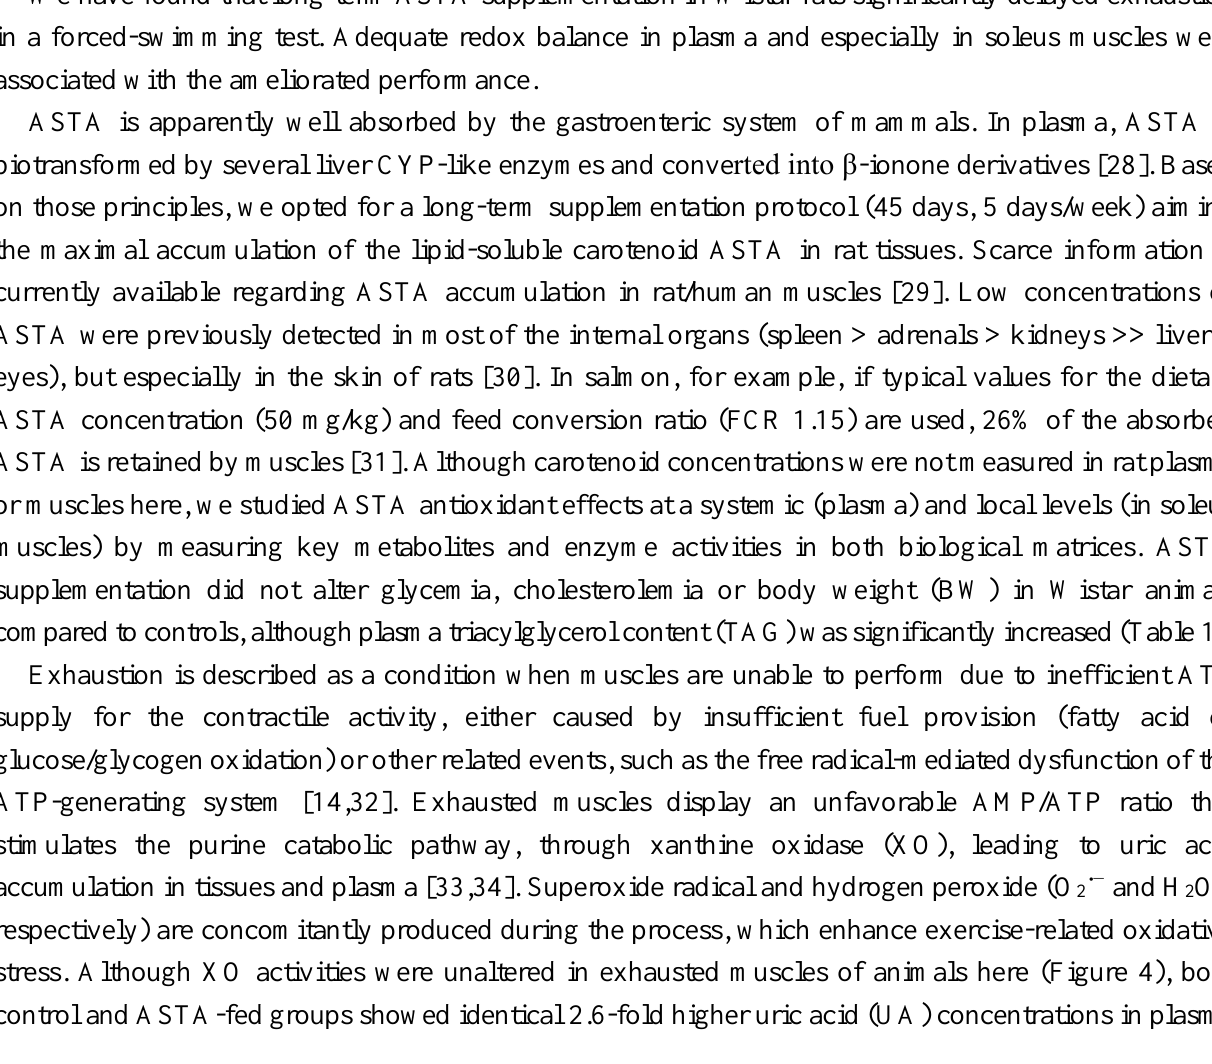
Table 3. Concentration of reduced (GSH), oxidized glutathione (GSSG), their ratio (GSH/GSSG), and protein thiol content in soleus muscles of Wistar rats submitted to exhaustion (forced swimming activity with additional 5% BW) and supplemented for 45 days with 1 mg ASTA/kg BW or mineral oil (control) ( n = 6). Parameters C C-EX ASTA ASTA-EX 64.54 ± 9.30 *(C), 37.14 ± 3.99 * (C), GSH (nmol/g tissue) 51.26 ± 0.91 ‡ (A), † (AE) † (CE), ‡ (A) GSSG (nmol/g tissue) 220.0 ± 4.0 Protein thiols 4.48 ± 1.62 (µmol-SH/mg prot) Ratio GSH/GSSG 0.656 ± 0.229 * 0.108 ± 0.026 * 0.233 ± 0.006 0.395 ± 0.072 * (C,A) (U.A.) (C,AE), ‡ (CE) * ( p < 0.05); † ( p < 0.01); ‡ ( p < 0.005), compared to: control (C), control exhausted (CE), ASTA-fed (A),